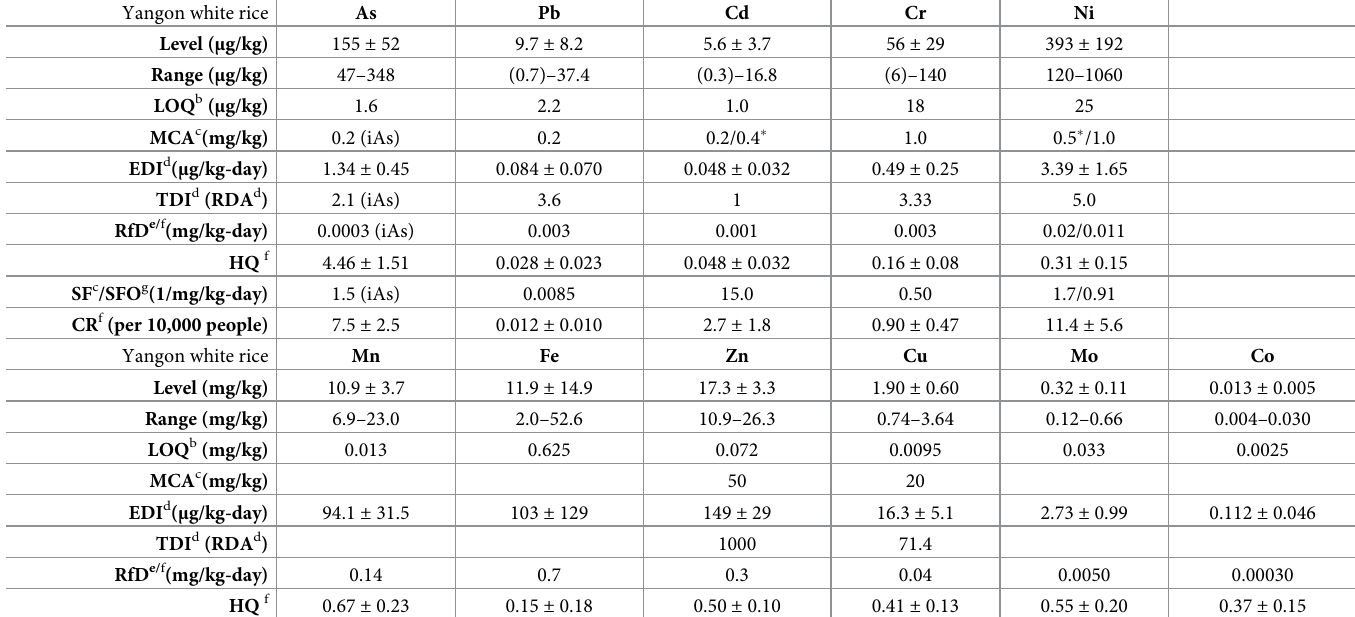
Table 1. Elemental concentration data in white rice samples, estimated average dietary intakes (EDI), and the potential health risks (CR per 10,000 people and HQ) with mean and standard deviation (SD) values. Yangon white rice